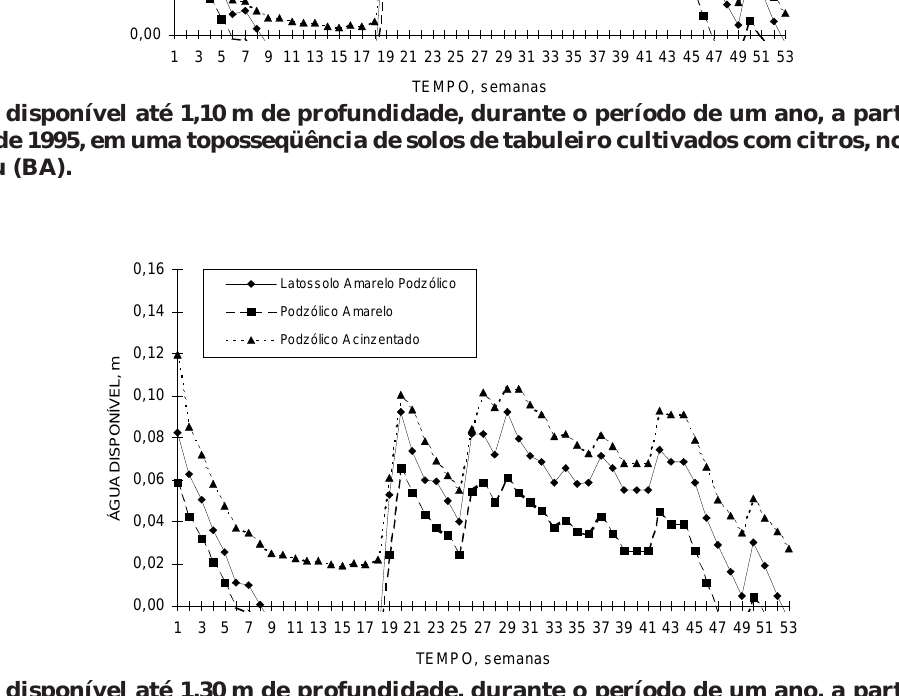
Figura 8. Água disponível até 1,30 m de profundidade, durante o período de um ano, a partir de 18 de dezembro de 1995, em uma toposseqüência de solos de tabuleiro cultivados com citros, no município de Sapeaçu (BA).